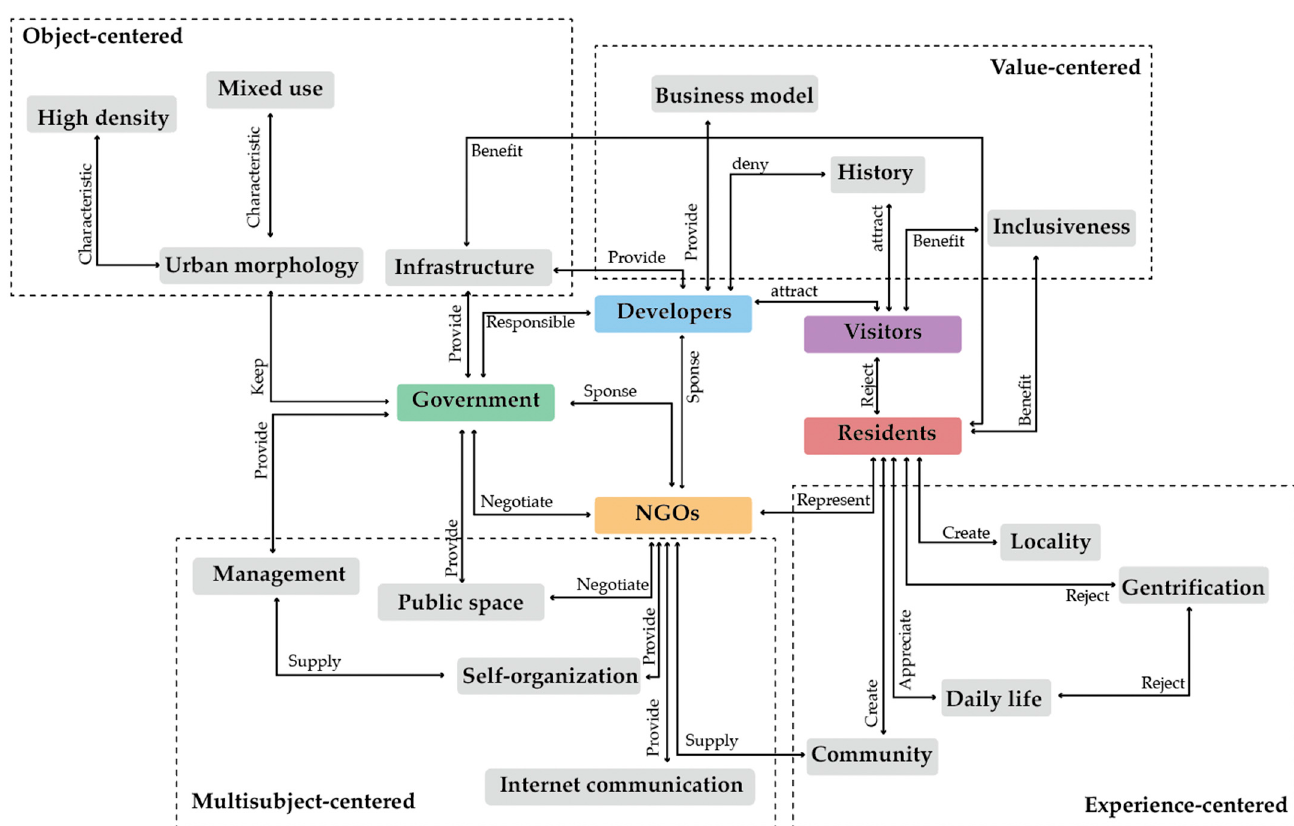
Figure 7. Network of core concepts and their relationship provided by groups of interviewees.